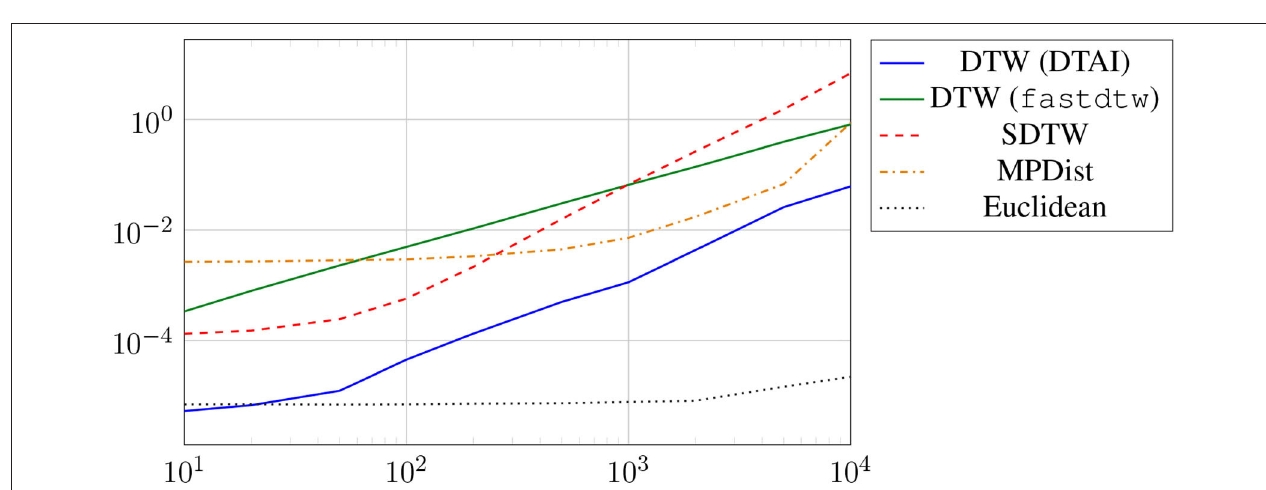
FIGURE 5 | Runtimes of distance computation between a single pair of time series with increasing length.